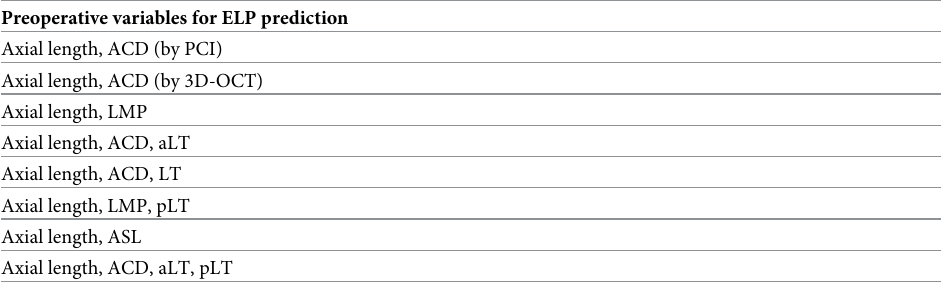
Table 2. The combinations of biometric measurement for effective lens position (ELP) prediction and intraocular lens power calculation.